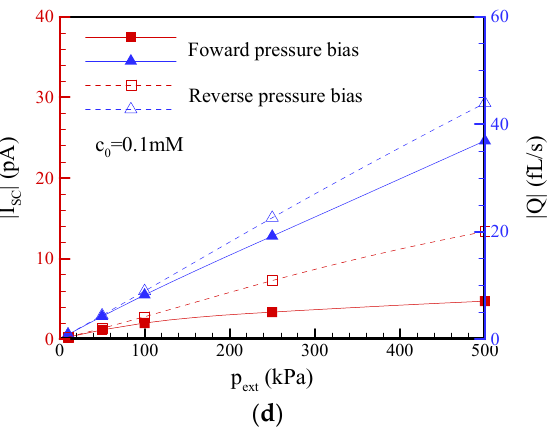
Figure 3. The dependence of the pressure bias on the open circuit voltage (V OC ), short circuit current (I SC ), and flow rate (Q) through a conical nanopore at salt concentrations of ( a , c ) c 0 = 1 mM; ( b , d ) c 0 = 0.1 mM. Note that θ = 1.2 ◦ , σ s = − 5 mC/m 2 , and b = 20 nm.